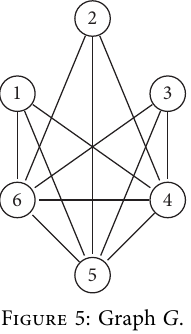
Figure 5: Graph G